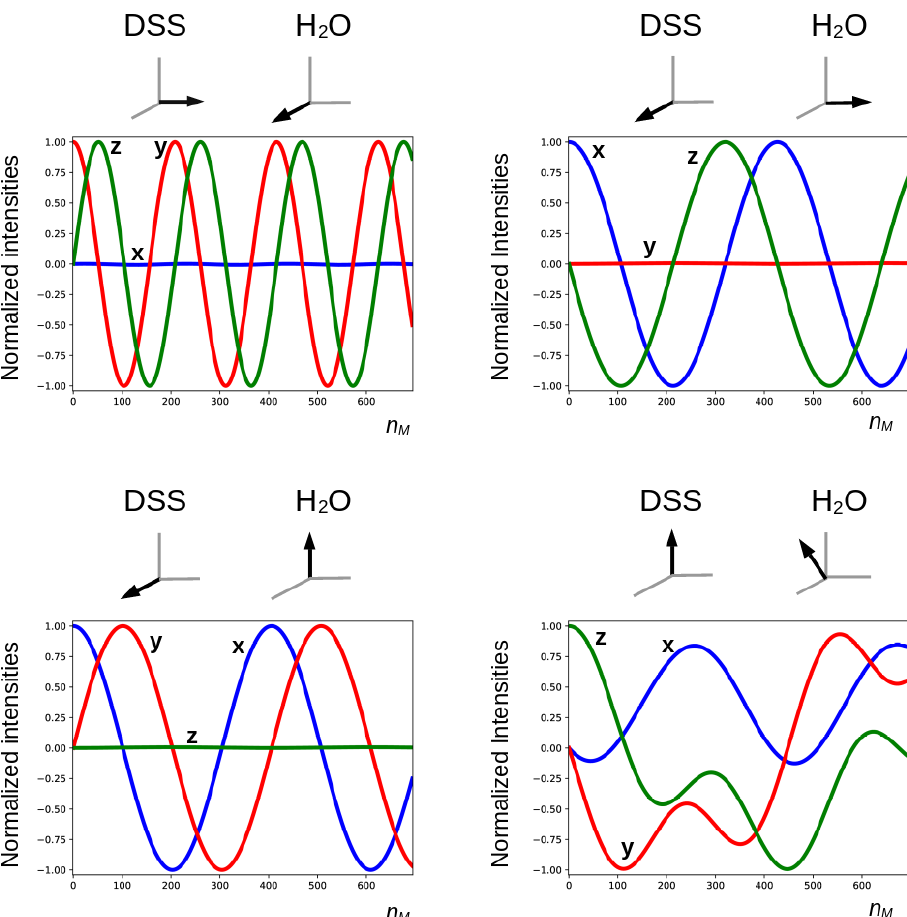
Figure 7. Simulated trajectories of the magnetization of the methyl groups of DSS under a DIPSI-2 pulse train with an RF amplitude of 100kHz (90 ◦ pulse of 2.5µs), with the carrier frequency set on the water resonance. On top of each graph, the initial magnetization just before the spin lock is shown (in the lower right corner, M A x (0) /M A eq = 0 . 411, M A y (0) /M A eq = − 0 . 310, M A z (0) /M A eq = 0 . 857). The RD parameters used for the simulations and the color code of the curves are identical to those used in Figs. 5 and 6. For clarity, the curves are also labeled with the corresponding direction of the magnetization. The maximum number of cycles n M = 694 corresponds to a duration of